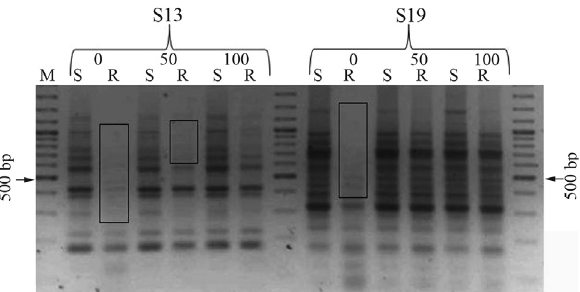
Figure 2 - RAPD results of primers S13 and S19. 0, 50 and 100 represent NaCl concentrations (mM). Polymorphic bands are indicated by rectan- gles.